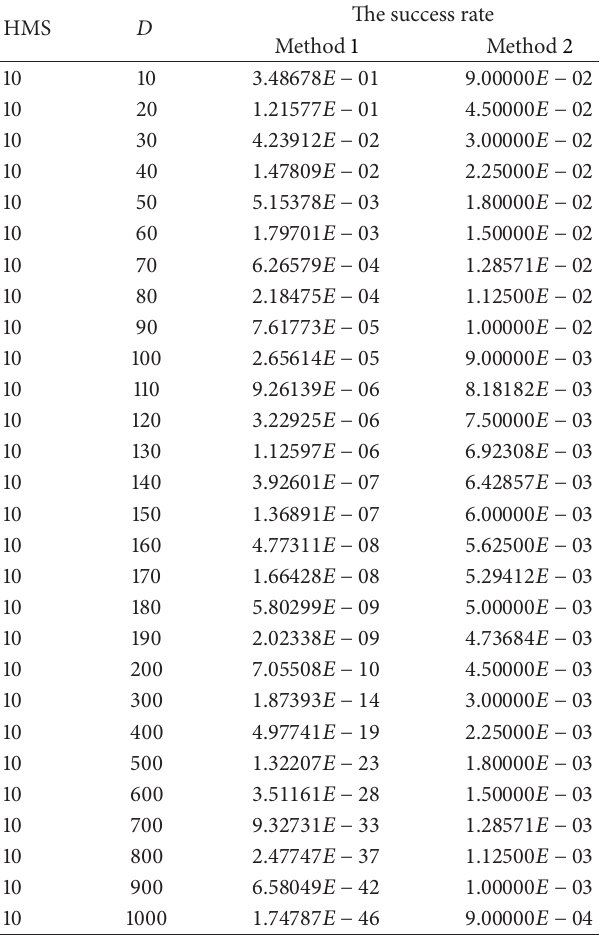
Table 1: Success rate of Methods 1 and 2.